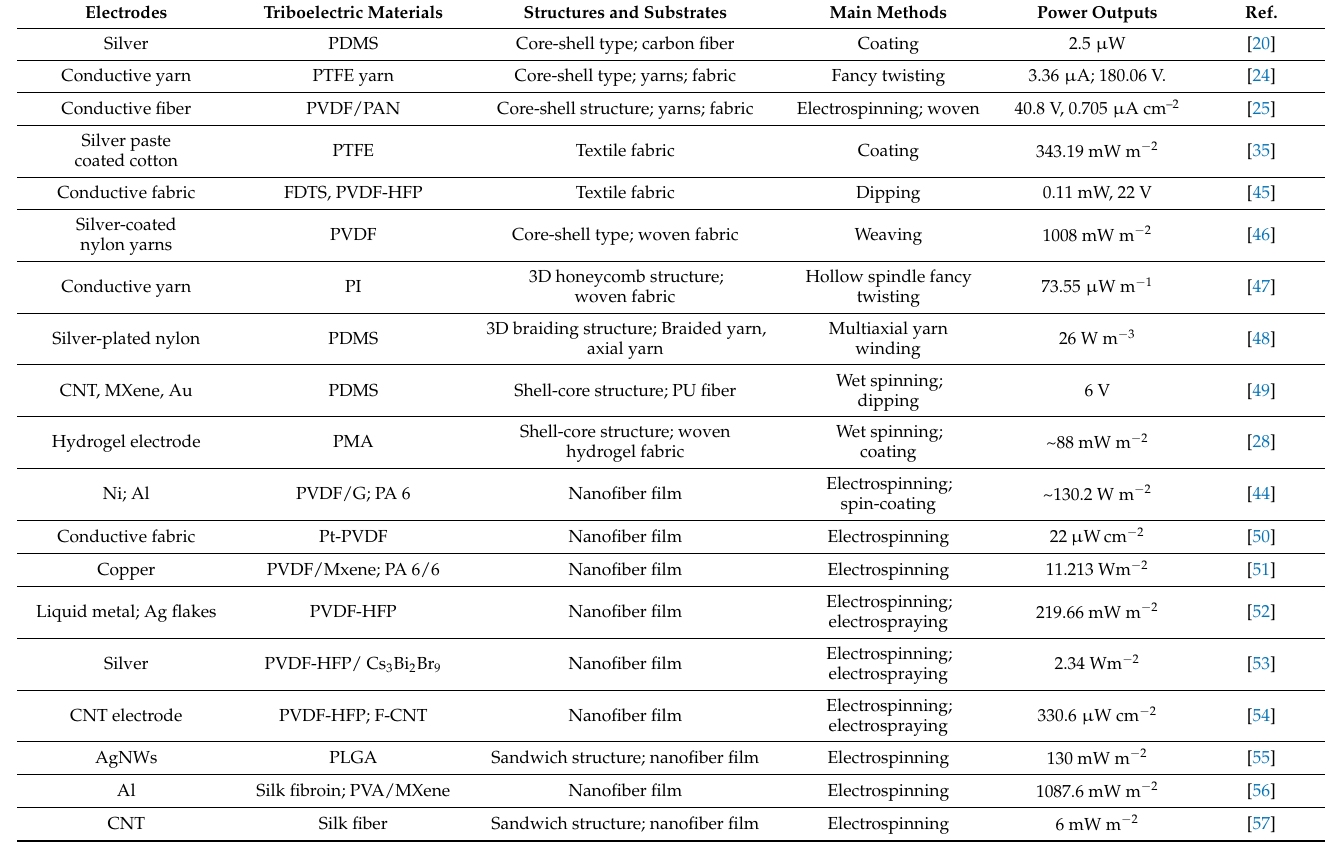
Table 1. Summary and comparison of fabric/fiber-based